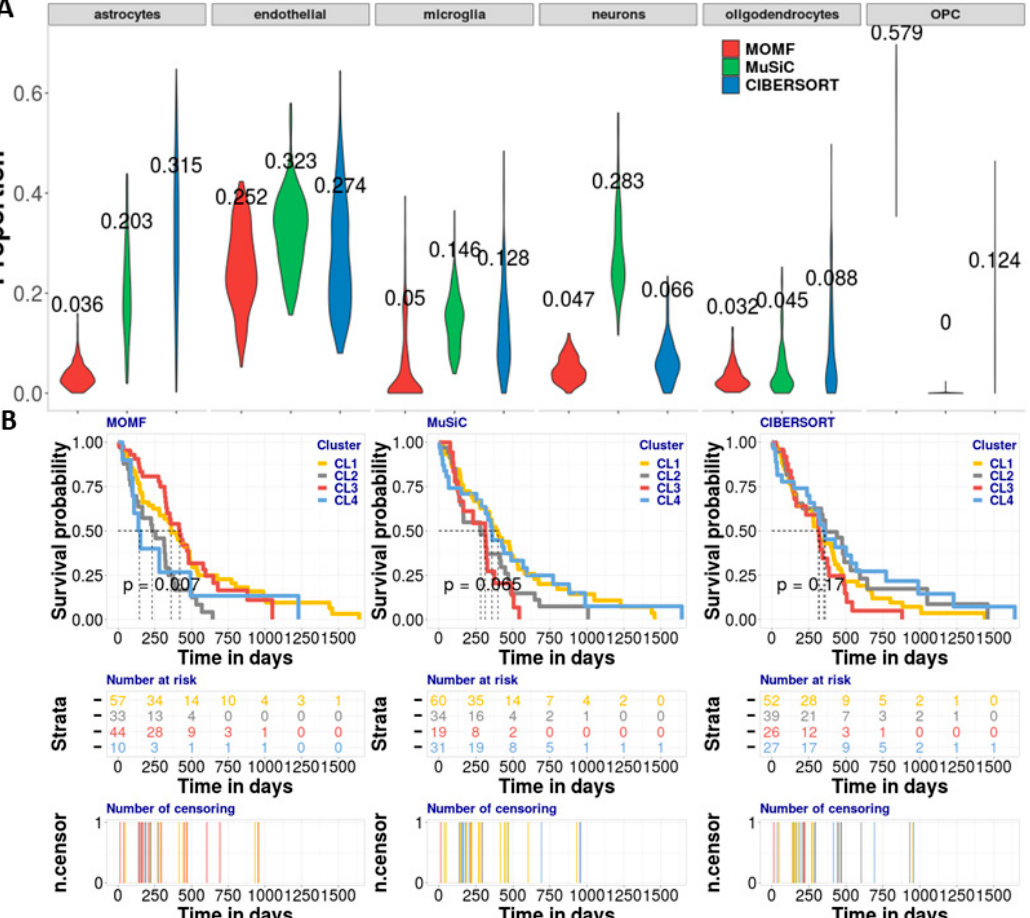
Figure 3. Analyzing GBM bulk RNA-seq data with brain scRNA-seq data. ( A ) The violin plot is to show the e ff ect proportion of each cell type from three di ff erent deconvolution methods. We found that the OPCs and endothelial cells are enriched by MOMF, which means that the two cell types potentially contribute to the survival of GBM. ( B ) The KM plots are used to show the survival analysis for four clusters from the TCGA bulk RNAseq data. We use log-rank test to compare the distributions of four clusters. MOMF grouped the GBM samples into four subtypes ( p -value = 0.007). The cluster CL4 is the poor-prognosis. Number at risk in the table shows the number of survival individuals at each 250